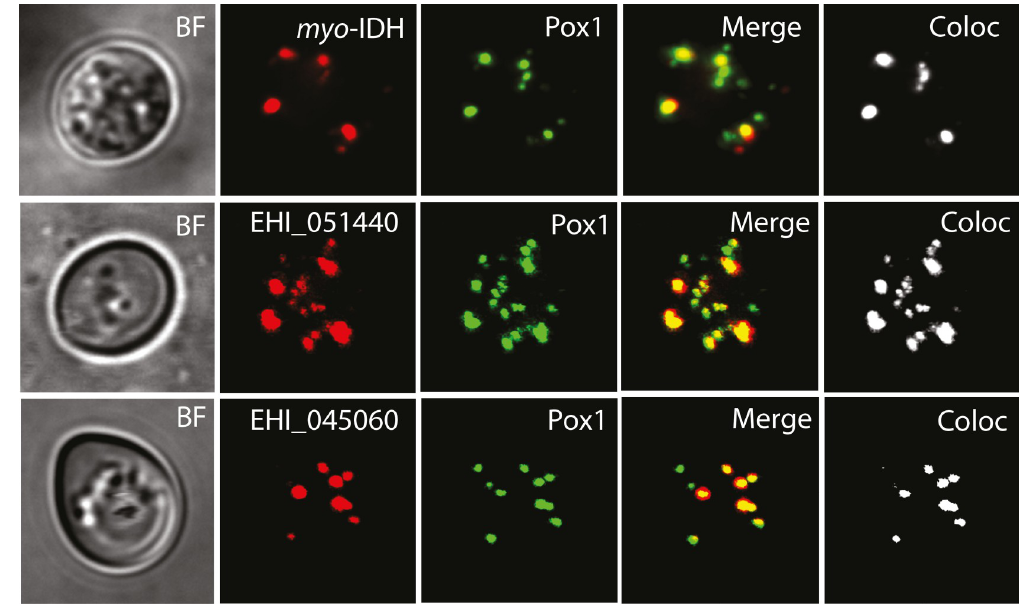
Fig 9. Localization of PTS1-containing candidate proteins in yeast peroxisomes. Fluorescence microscopy of mCherry- tagged myo -IDH and two hypothetical proteins (EHI_051440 and EHI_045060) (red) expressed in yeast. Pox1 fused with GFP was used as a peroxisomal marker (green). Signal colocalization analysis (white) was performed by ImarisColoc software.